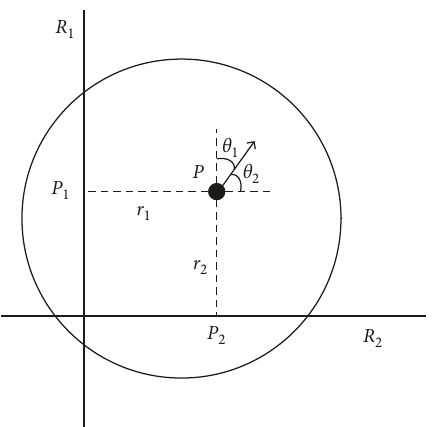
Figure 3: Basic principle of the direct projection